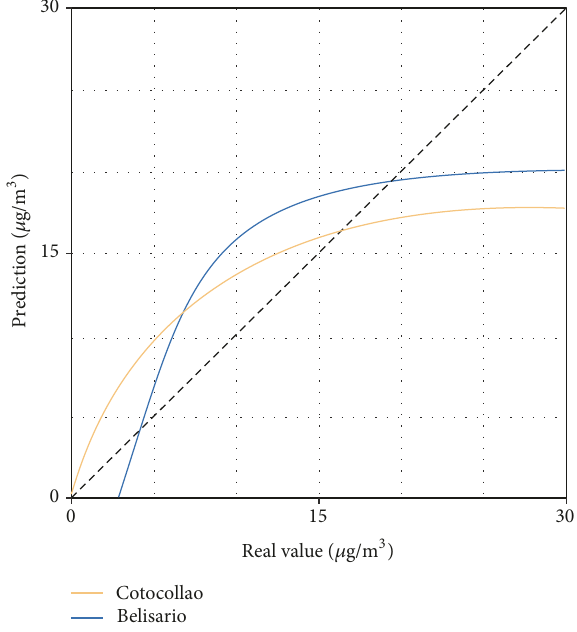
Figure 10: Fitted lines representing the correlation between pre- dicted values and real values through a NN algorithm for Cotocollao (orange) and Belisario